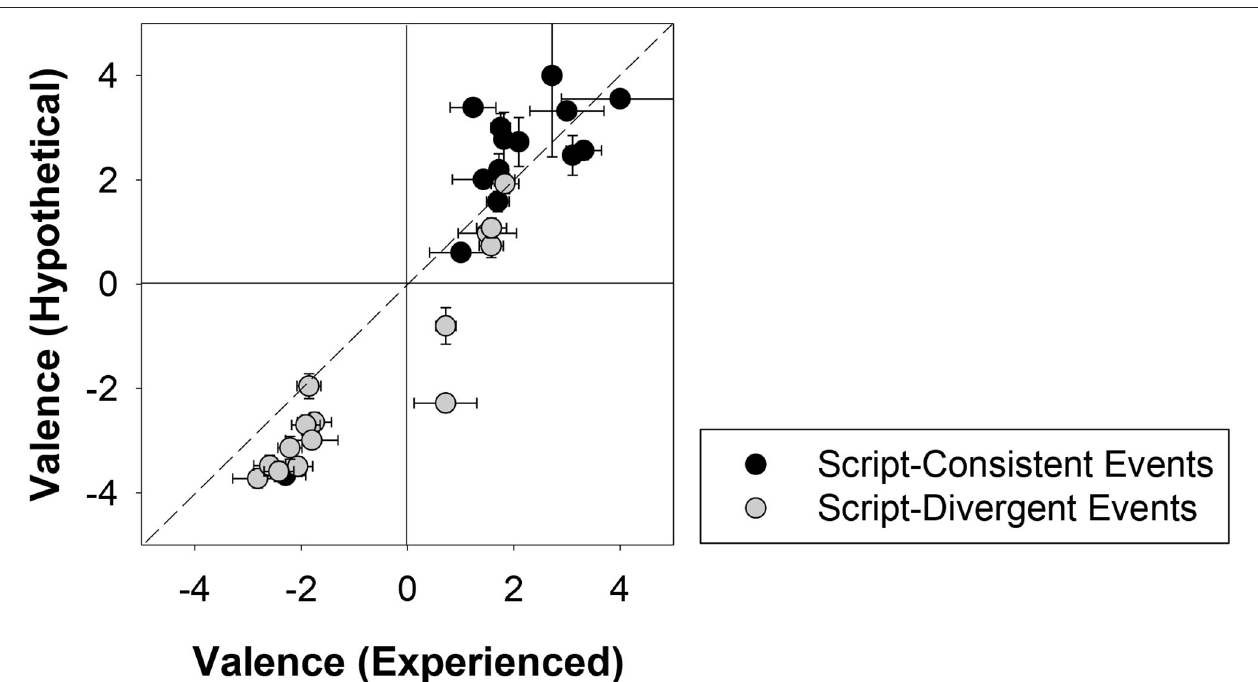
FIGURE 4 | Mean ratings of the valence of script-consistent events and script-divergent events in the experienced condition (participants’ real life) and the hypothetical condition (an average Canadian’s life). Error bars indicate ± 1 standard error of mean. The event, “begin grade school,” is omitted in this graph because it only has estimates from the experienced condition ( M = 2.10, SE =